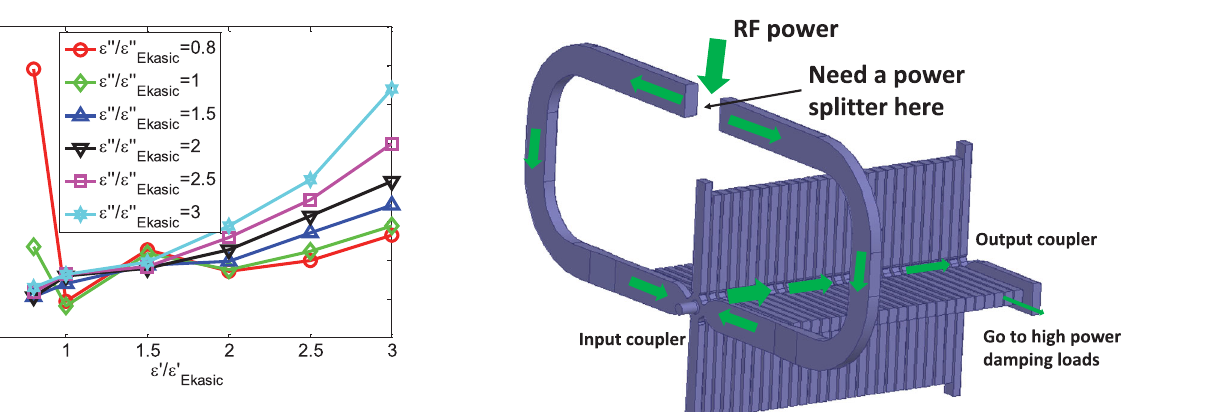
FIG. 23. Wakefield suppression for rf loads ( F various material properties ( ε 0 : real part of permittivity; ε 00 : imaginary part of permittivity). FIG. 24. Power coupling circuit of CLIC accelerating structure.